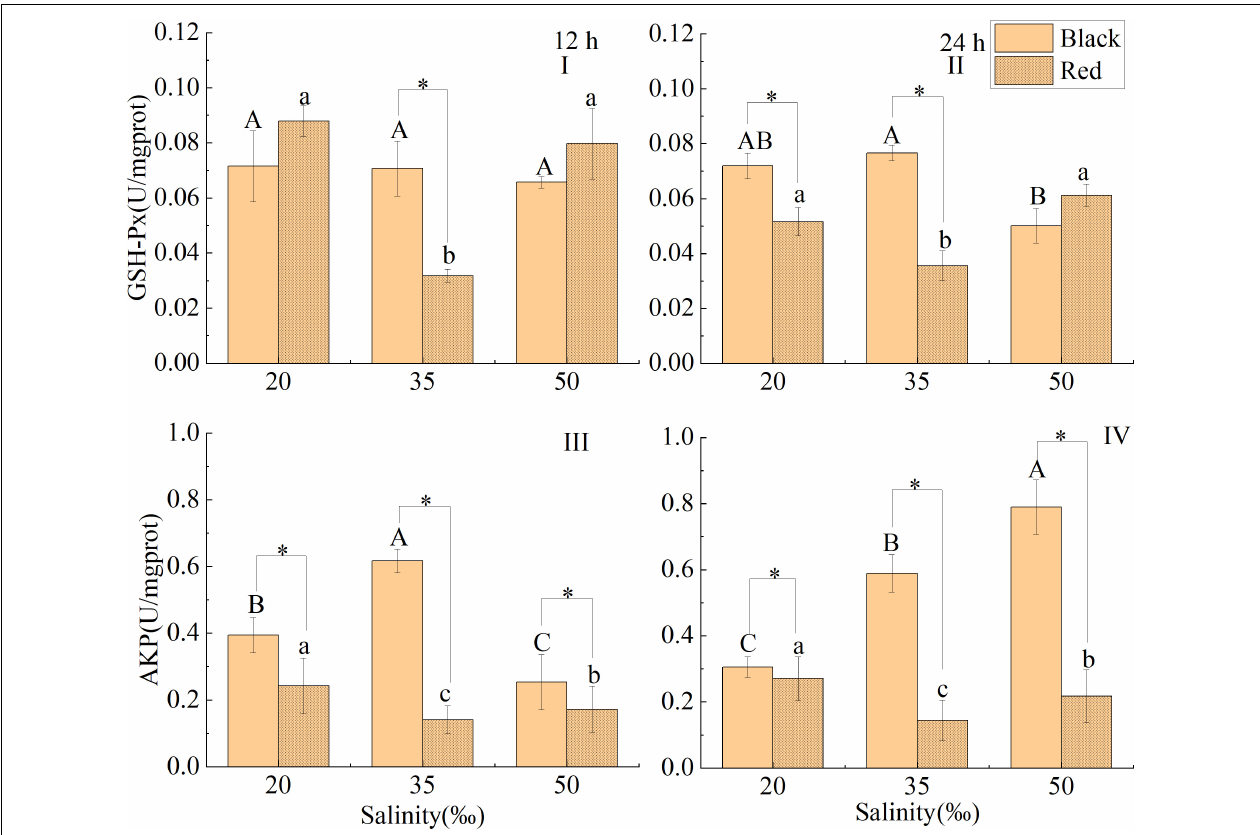
FIGURE 7 | Effects of salinity on GSH-Px and AKP activities in the liver tissue of P. fucata with two shell colors (I: 12h, GSH-Px activity; II: 24h, GSH-Px activity; III: 12h, AKP activity; IV: 24h, AKP